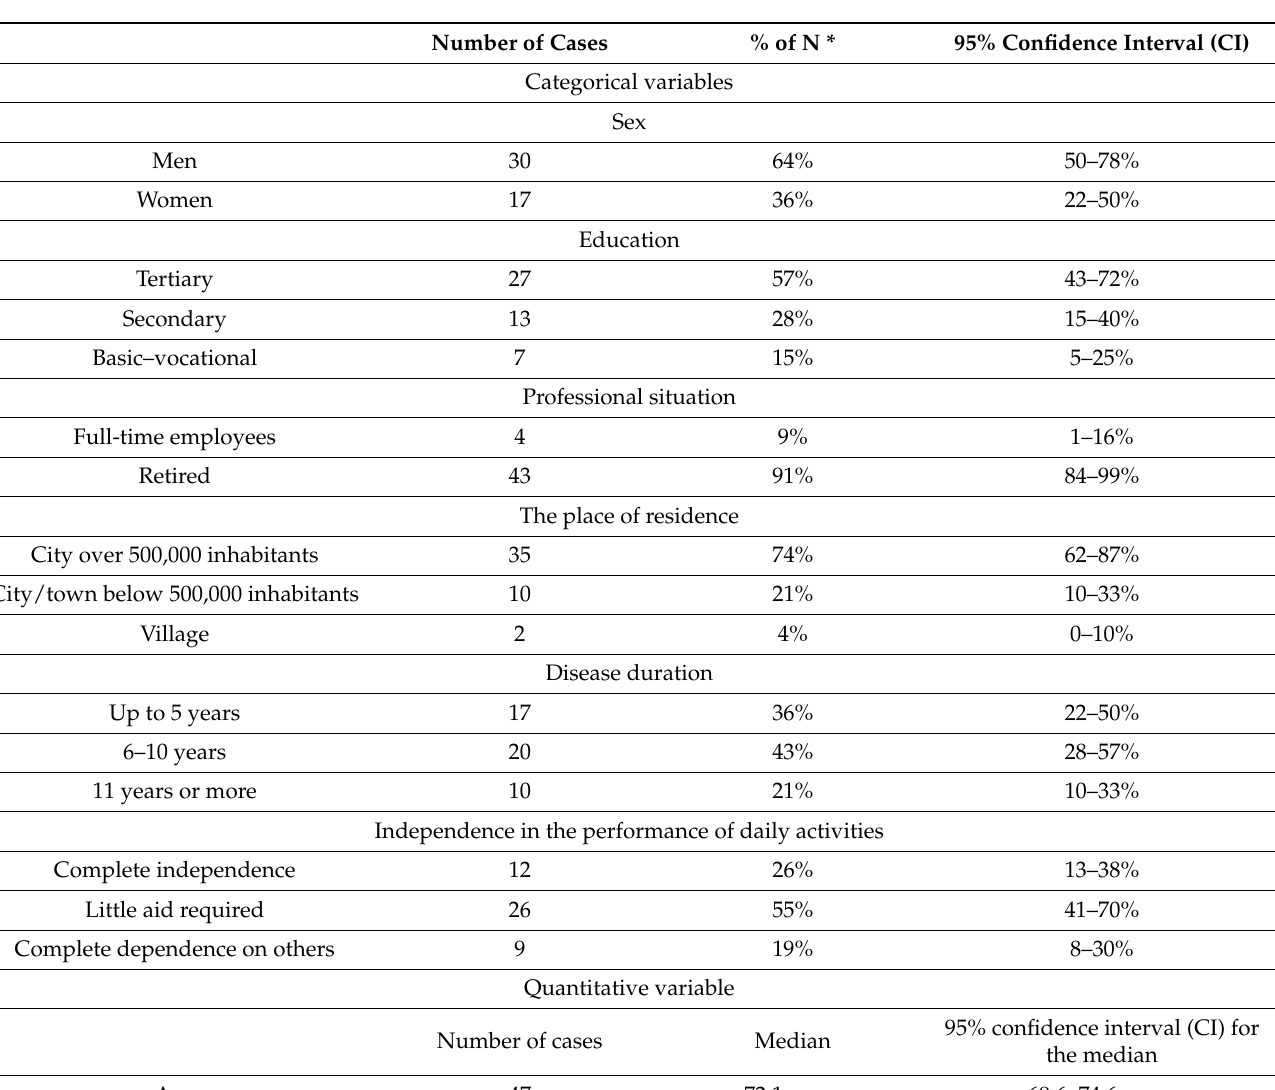
Table 1. Characteristics of the study group (N = 47